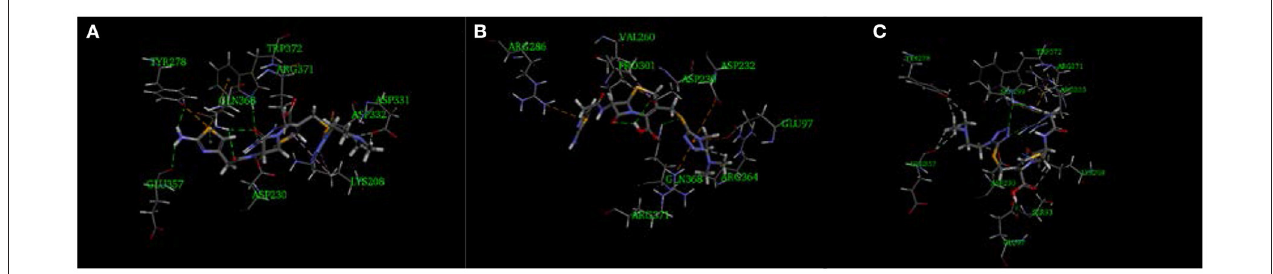
FIGURE 5 | Three-dimensional ligand docking model, showing the interactions of (A) cefotiam, (B) impurity 1, and (C) impurity 2 with residues in the active site of the HAS1 protein. The arrows indicate hydrogen bonds.